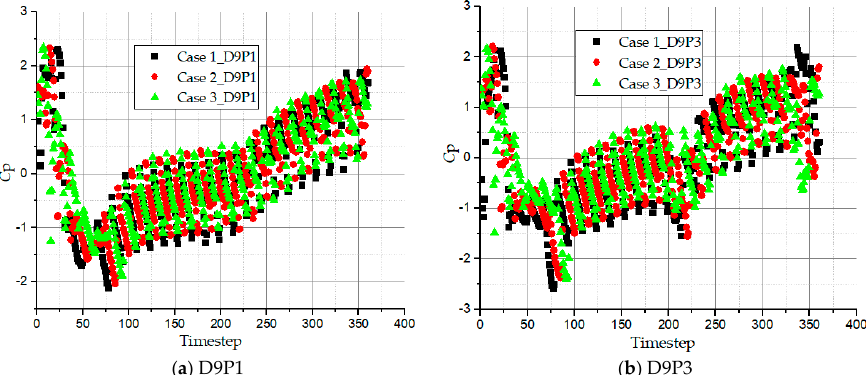
Figure 15. Time domain history of pressure fluctuation coefficient in impeller passage at outflow region for all pump cases.